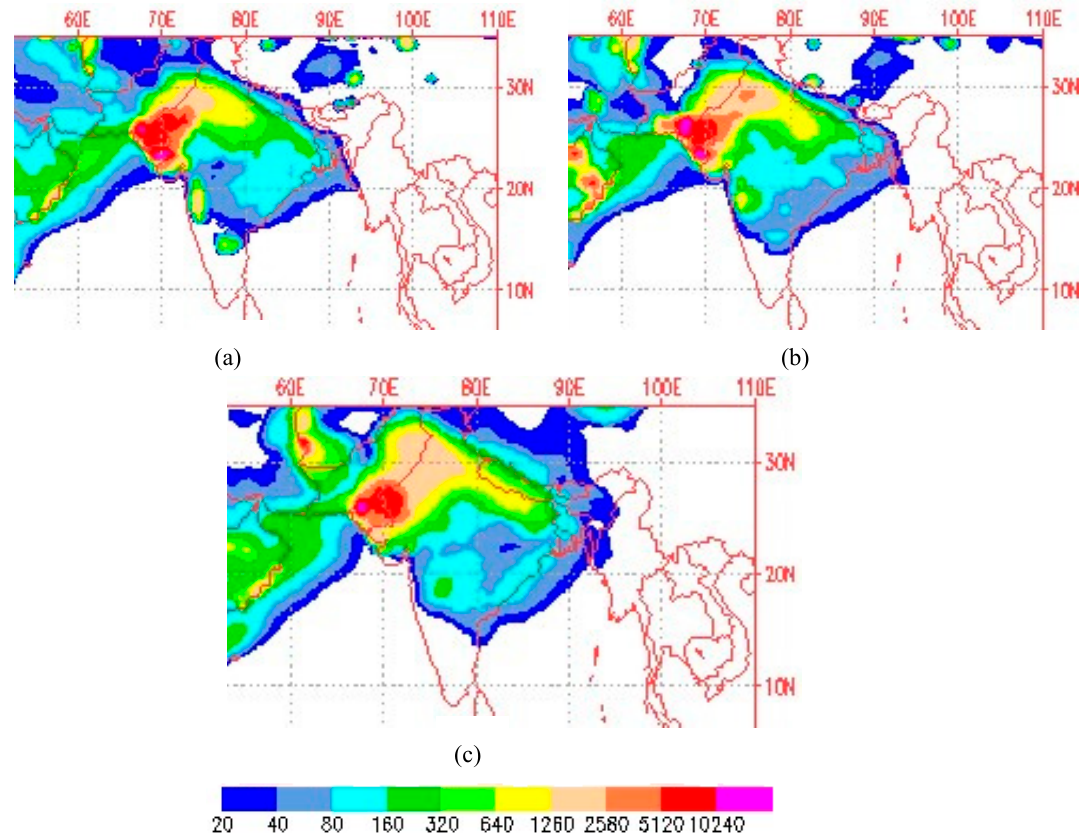
Figure 5. ( a ) Dust concentration ( μ g/m 3 ) at 0060 UTC on 13 June 2018 (Green and yellow show the dust and red shows sulfate (horizontal resolution of 1 × 1°)) [28]; ( b ) Dust concentration ( μ g/m 3 ) at 1200 UTC on 13 June 2018 (Green and yellow show the dust and red shows sulfate (horizontal resolution 1 × 1°)) [28]; ( c ) Dust concentration ( μ g/m 3 ) at 1800 UTC on 14 June 2018 (Green and yellow show the dust and red shows sulfate ( horizontal resolution of 1 × 1°)) [28].